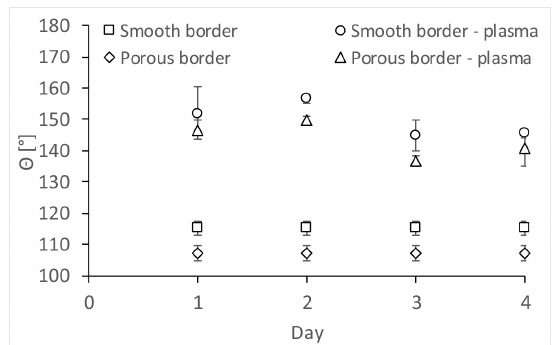
Figure 5. Water contact angle vs. time on the plasma-treated samples of PS substrates with smooth borders and porous borders and two cycles of plasma treatment. The smooth borders were prepared by five doses of 1.5 THF:8.5 ETH, at 295 K. The porous borders were prepared with five doses of 2.5 THF:7.5 ETH at 303 K. The power of the plasma reactor was 300 W.